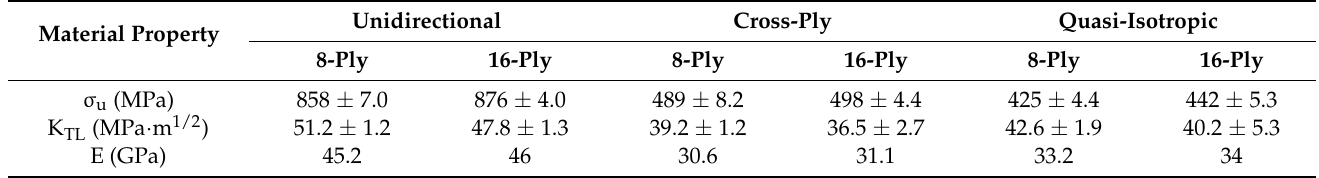
Table 2. Mechanical properties of the different ply configurations employed [21]. Unidirectional Cross-Ply Material Property